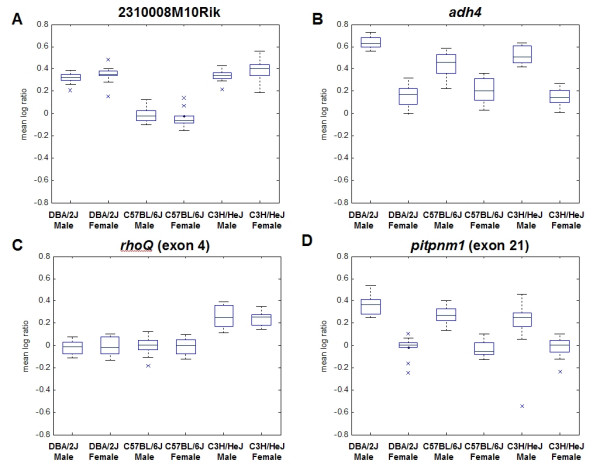
Examples of differentially expressed genes and splice forms. Box plots of the mean log ratio obtained from multiple probes in each strain-sex group for a single gene. The solid horizontal line across the length of the graph represents the average gene expression. The two dashed horizontal lines mark plus and minus two standard deviations from the average gene expression, respectively. For the boxes, from bottom to top, the solid horizontal lines represent the minimum mean log10 expression ratios excluding outliers, the lower quartile, the median, the upper quartile and the maximum mean log10 expression ratios excluding outliers. The dashed vertical lines represent the range of mean log10 expression ratios excluding outliers. Outliers are defined as any data-points having values extending beyond 1.5 times the interquartile range from either ends of the box. A) Box plots of 2310008M10Rik showing strain effect (p-value < 1 × 10-16); B) Box plot of adh4 showing sex effect (p-value < 1 × 10-16). C) Boxplots of rhoQ, exon 4 showing strain effect (p-value < 1 × 10-16); D) Boxplots of pitpnm1, exon 21 showing sex effect (p-value < 1 × 10-16)